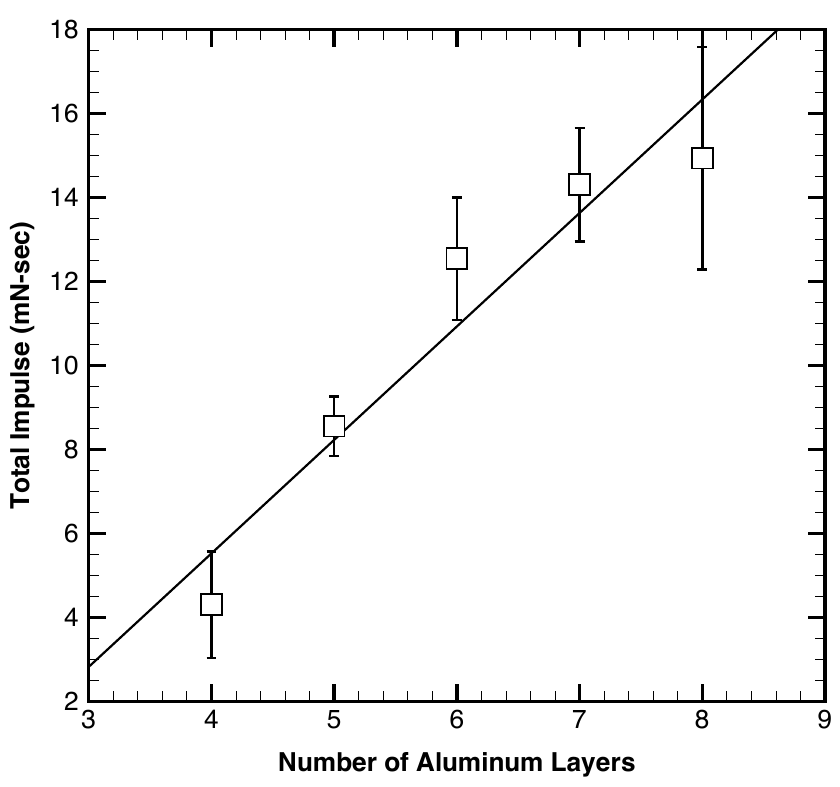
Figure 10. Average total impulse from four test trials as a function of the rupture of the number of aluminum layers (i.e., burst pressure). The aluminum layers have an average thickness of 0.016